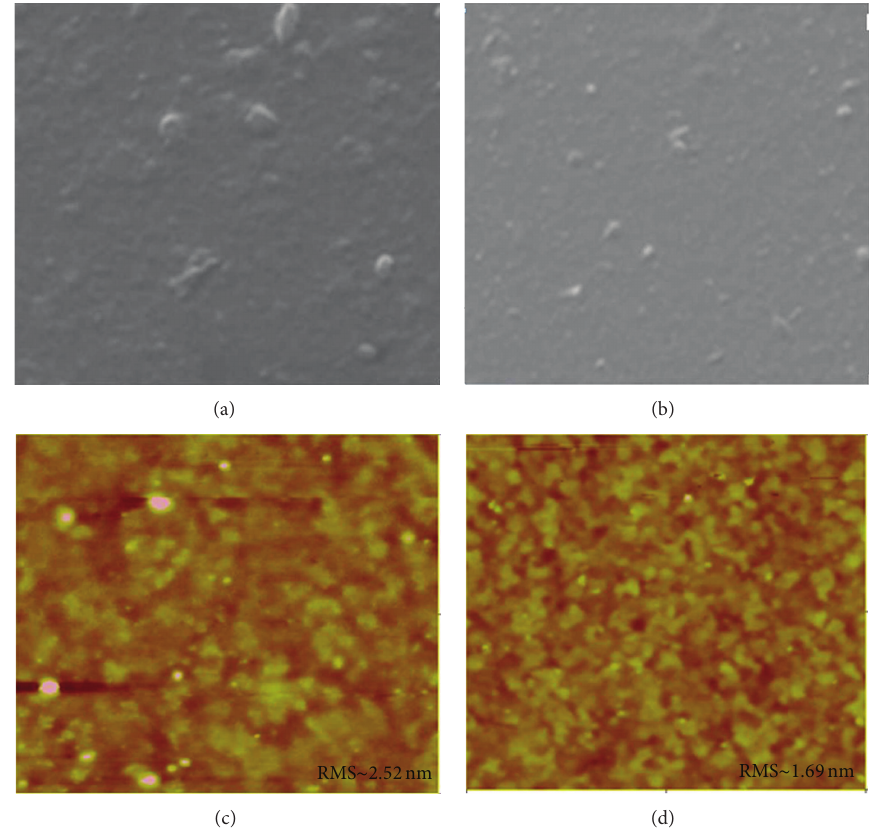
Figure 6: Scanning electron microscopic (SEM) image and surface roughness (RMS) of the (CdSe+PCPDTBT) (7:3) active layer annealed at 150 ∘ C with (a, c) OPA-capped and (b, d) BA-capped